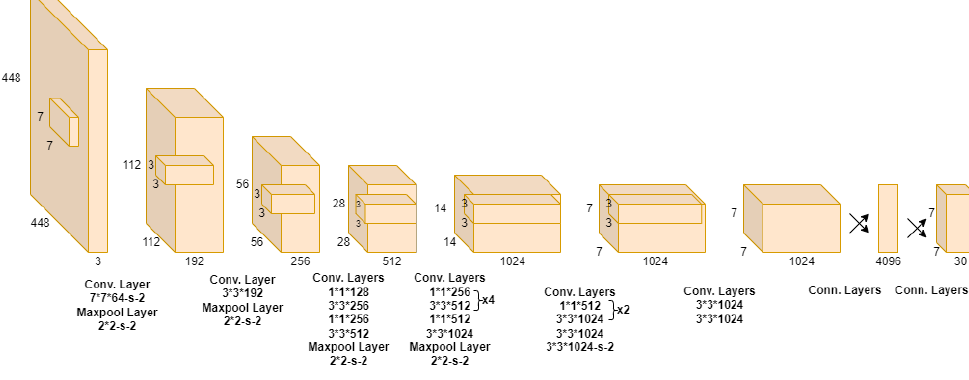
Figure 3. Architecure of